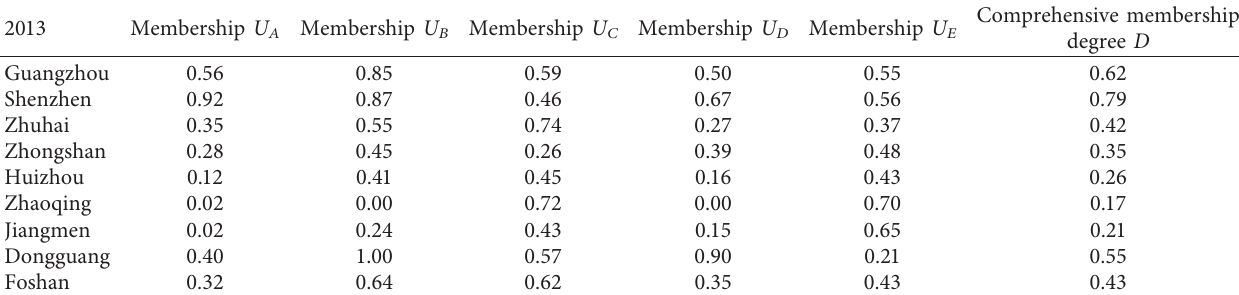
Table 12: First-level membership of the happiness index of nine cities in the Pearl River Delta in